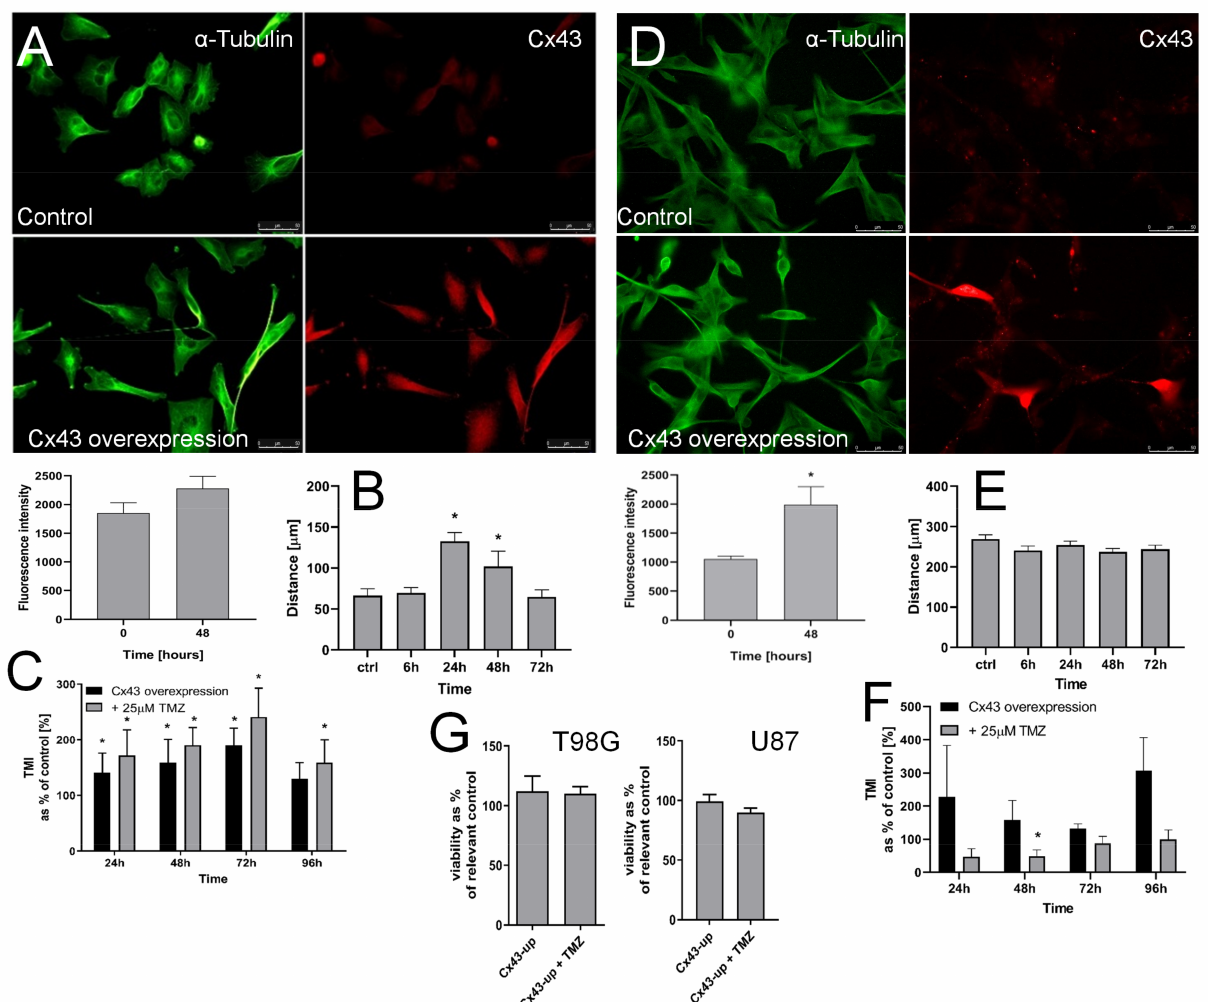
Figure 6. Effect of Cx43 up-regulation on the invasiveness of GBM cells. ( A ) T98G cells were transfected with Cx43 expression plasmid, followed by cytofluorimetric (FACS) estimation of intracellular Cx43 levels and the analyses of T98G morphology. Scale bar 50 µ m. ( B ) T98G cells were processed as in A and their motility was estimated after 24, 48, and 72 h with time-lapse video microscopy. ( C ) The effect of Cx43 up-regulation on the transmigration of T98G cells through the microporous membranes in the presence of 25 µ M TMZ. ( D ) Effect of Cx43 expression plasmid on the levels of Cx43 in U87 populations estimated with flow-cytometry. Scale bar 50 µ m. ( E , F ) Time-lapse and Transwell estimation of U87 motility/invasiveness estimated six, 24, 48, 72, and 96 h after the onset of transduction with Cx43 expression vector. Scale bars 50 µ m Statistical significance was calculated with non-parametric Mann-Whitney test, * p < 0.05 vs. control. Data representative for three independent experiments. Note the correlation between epithelial-mesenchymal transition (EMT)-related morphological changes, Cx43 up-regulation, and invasiveness of T98G cells in the presence of